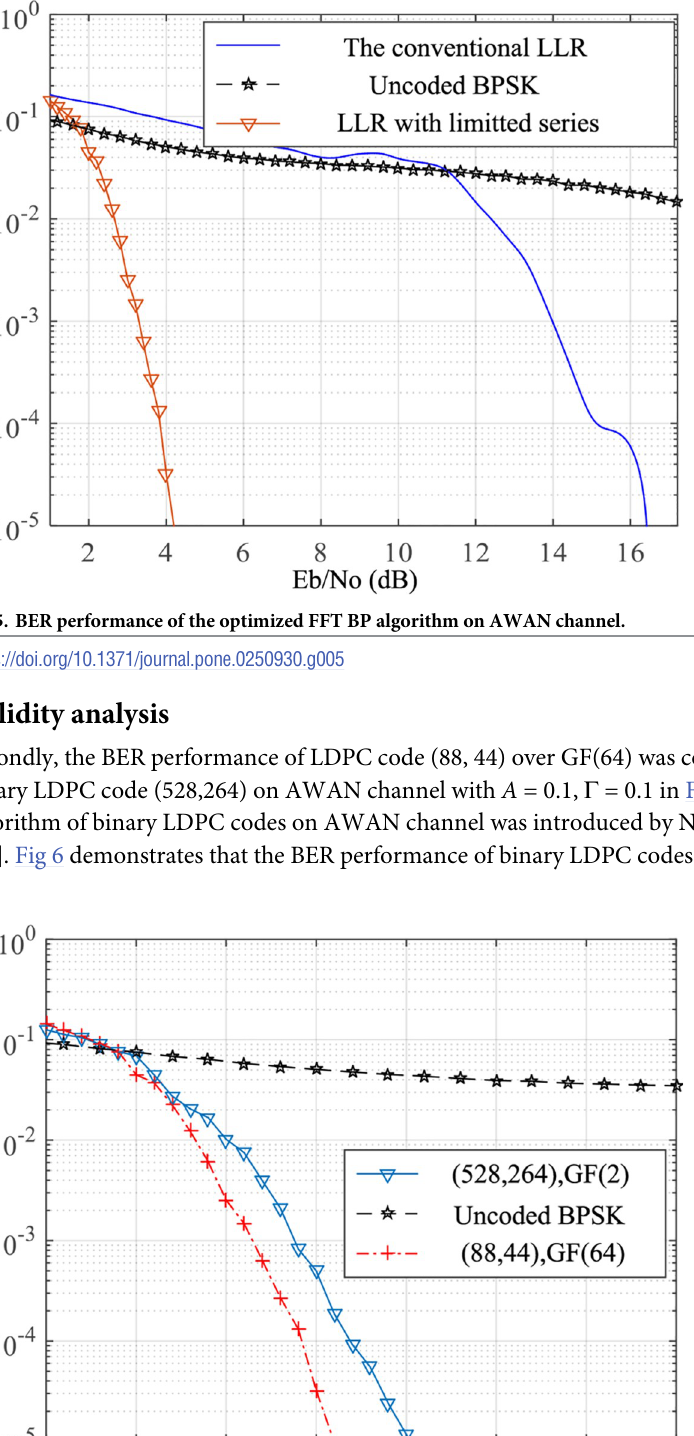
Fig 6. Performance comparison of LDPC codes over GF(2) and GF(64) on AWAN channel.